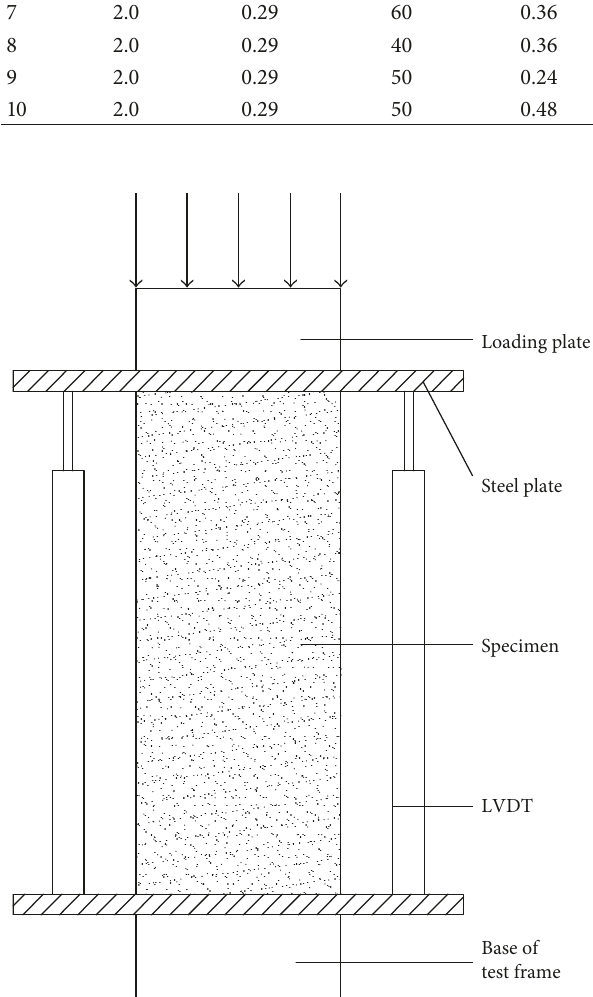
Figure 1: The schematic diagram of test